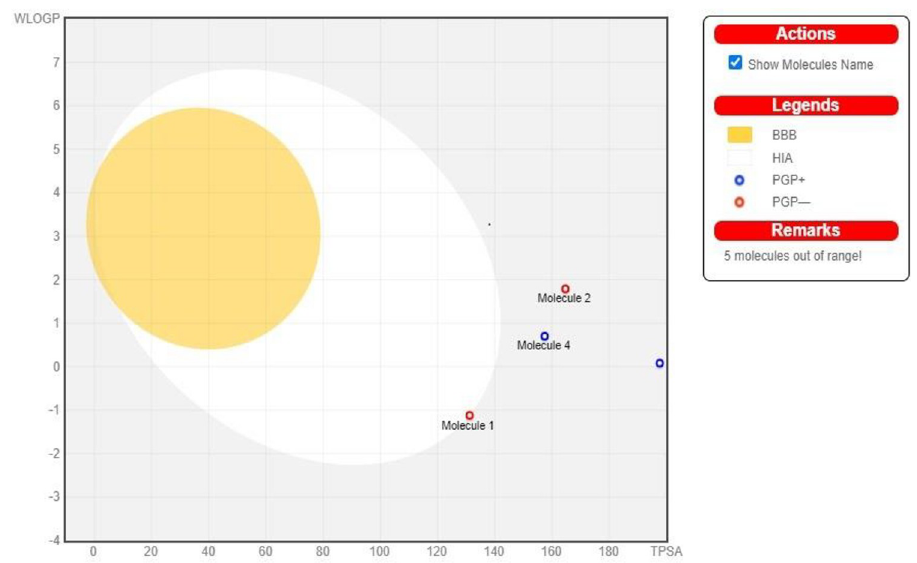
Fig 5. Egg plot "a correlation between antibacterial activity and ADME